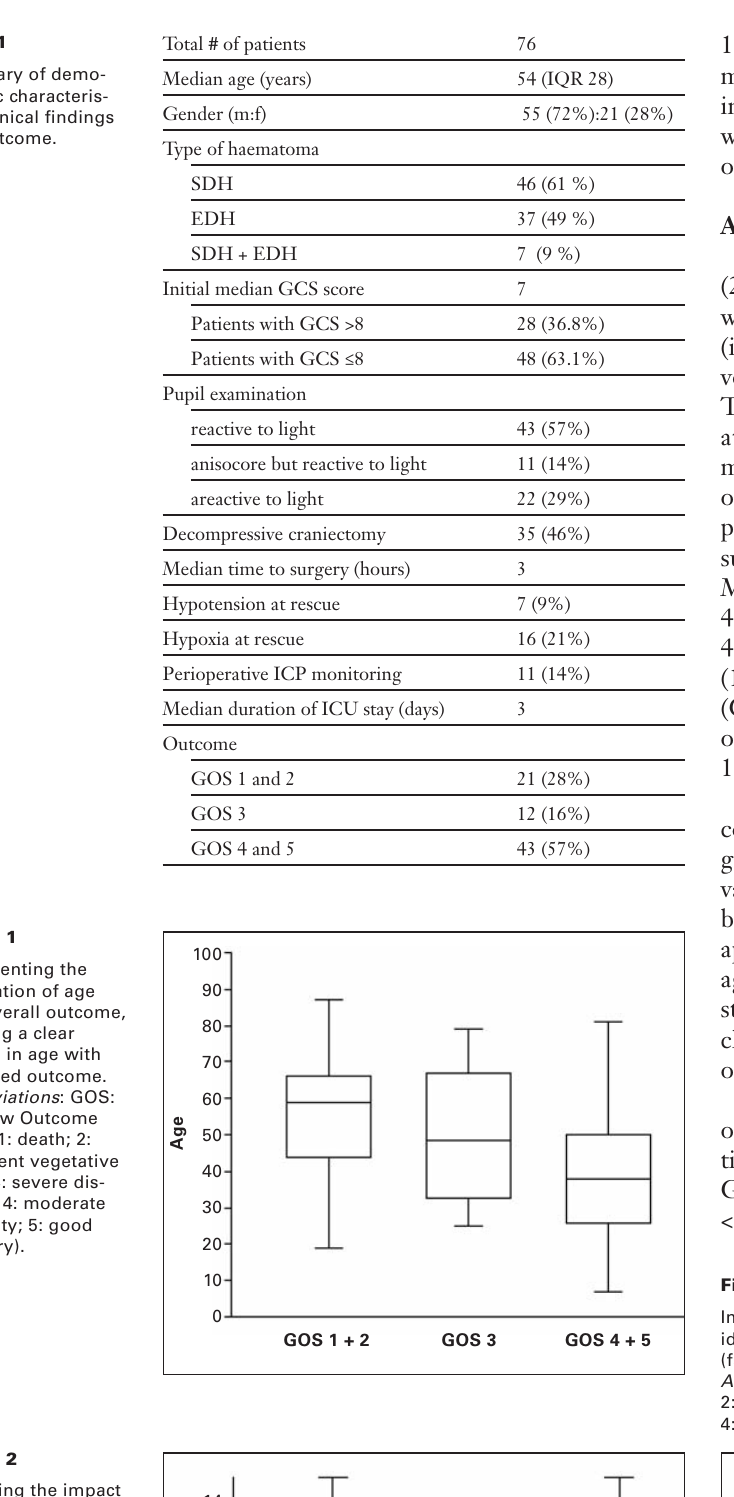
Analysing the impact of initial GCS on overall outcome: Similar distribution of initial GCS for un- favourable outcome (GOS1-3); with favourable outcome (GOS 4 and 5) associ- ated with a higher initial GCS (GOS 4 and